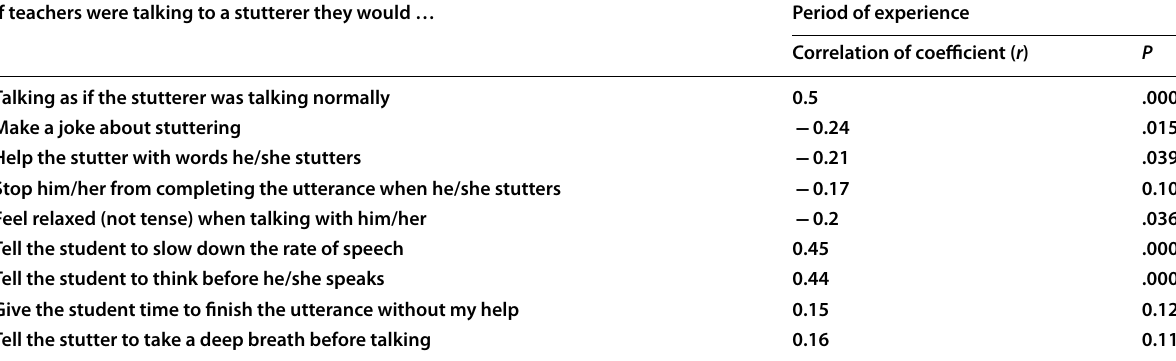
r Pearson’s correlation, P * < 0.05 (significant), P ** < 0.001 (highly significant)